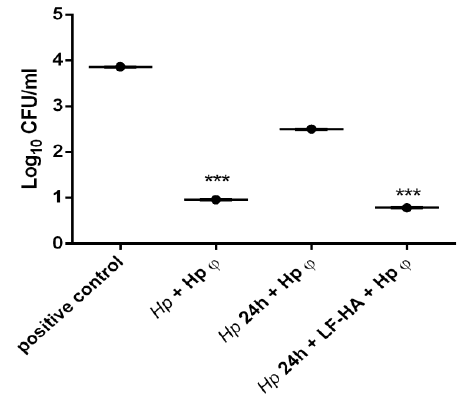
Figure 4. Modulation of antimicrobial effects against Helicobacter pylori on AGS cells. Antimicrobial activity of different treatments against Hp (10 6 CFU/mL). Results are presented as mean value ± SD and are representative of three independent experiments, each performed in triplicate. *** p value < 0.001.